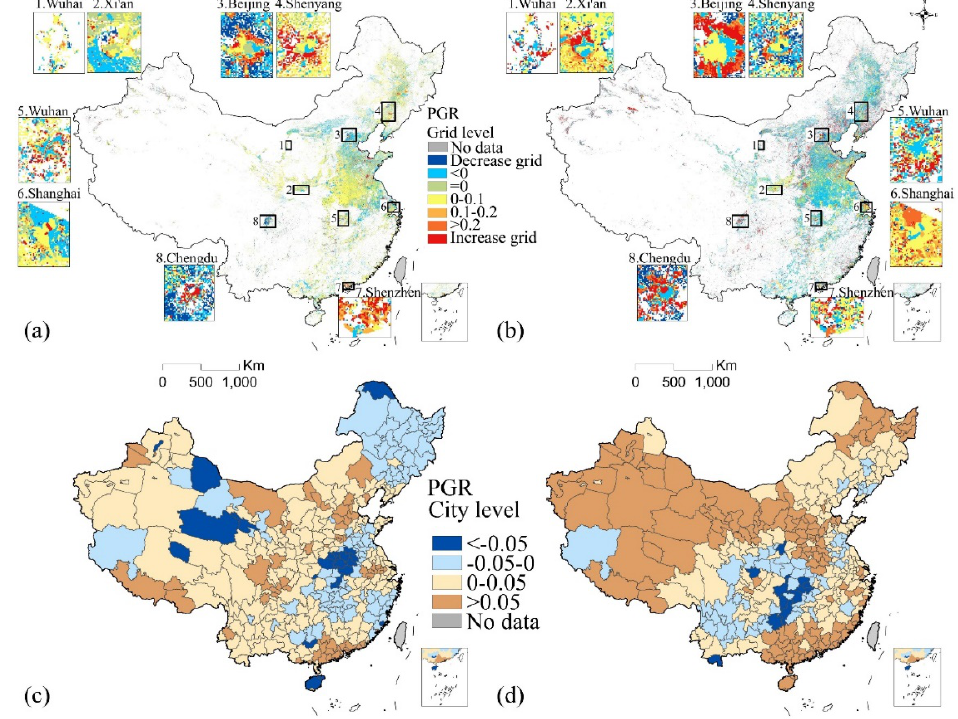
Figure 6. The PGR value in China in 1990–2010. ( a , b ) The spatial distribution of the PGR at the 1 km × 1 km grid level; the increased grid indicates that the initial map has no population in the grid and the final image has a population in the grid, while the decrease grid means the opposite. ( c , d ) The spatial distribution of the PGR at the city level. ( a , c ) The PGR value in 1990–2000. ( b , d ) The PGR value in